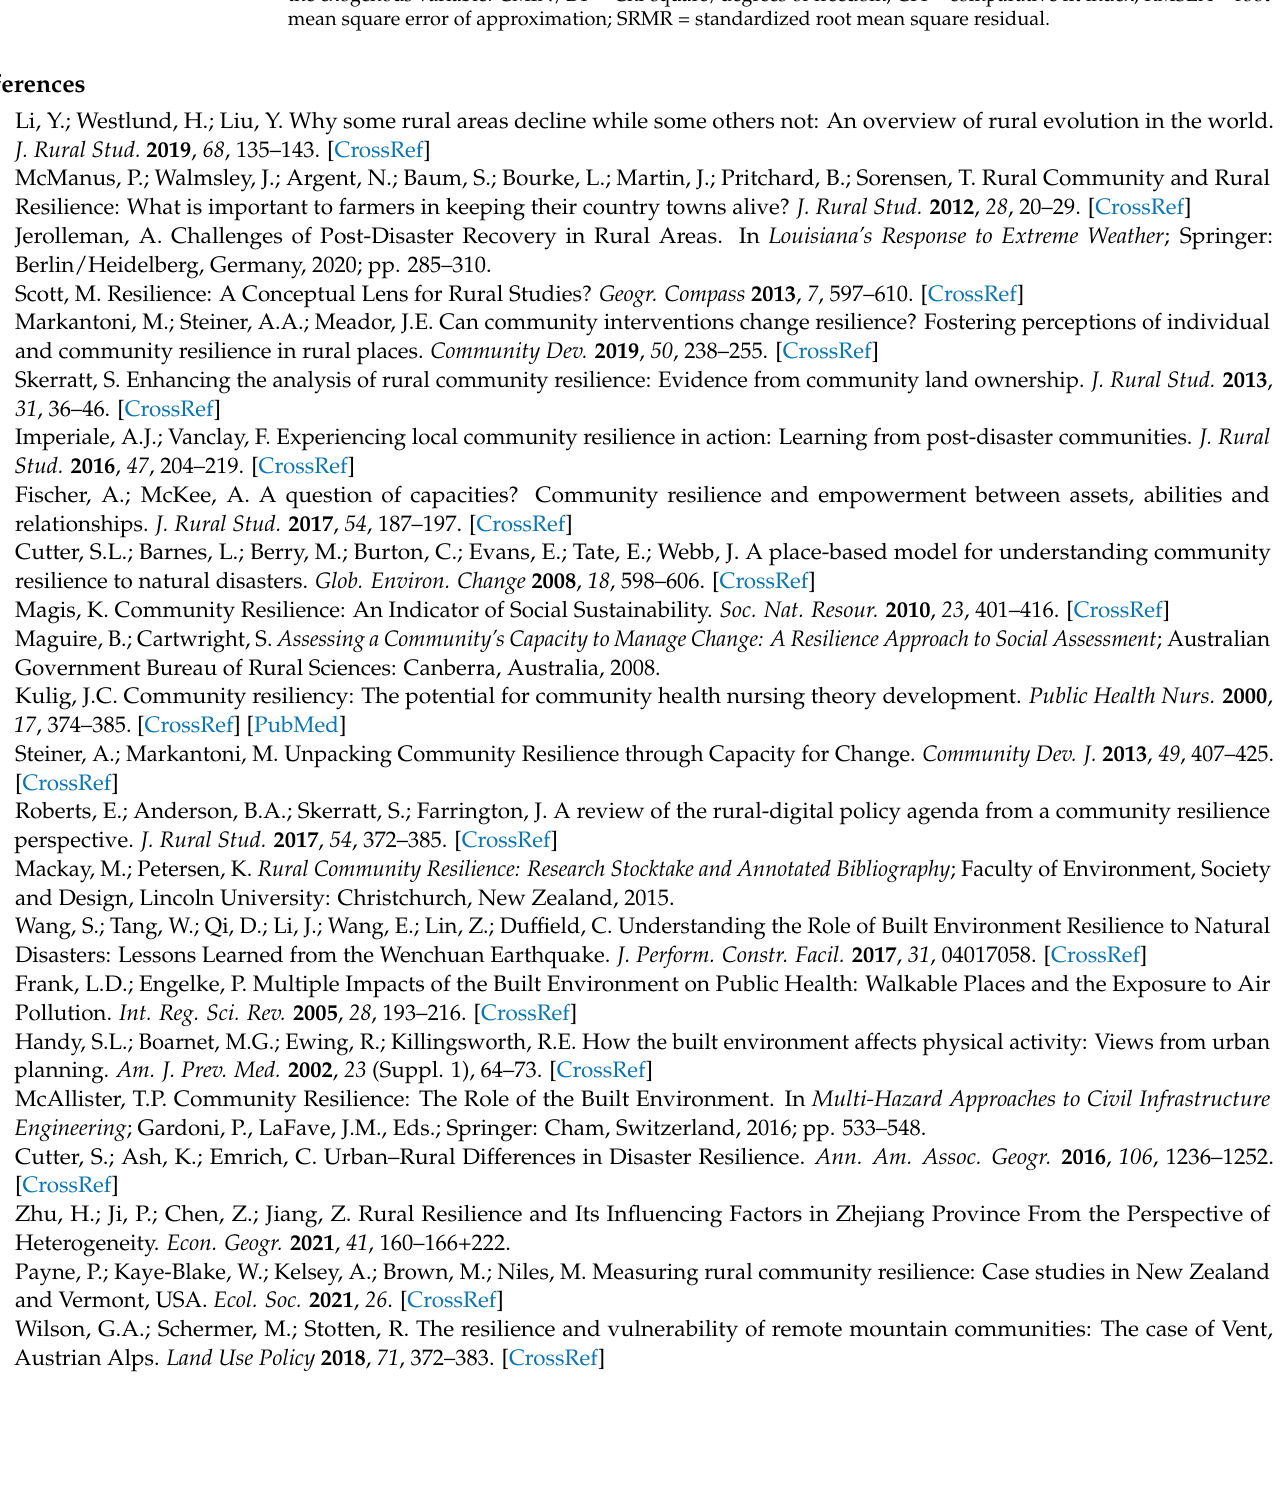
with population density as the exogenous variable; Model 4 refers to community-level model with accessibility as the exogenous variable. CMIN/DF = Chi-square/degrees of freedom; CFI = comparative fit index; RMSEA = root mean square error of approximation; SRMR = standardized root mean square